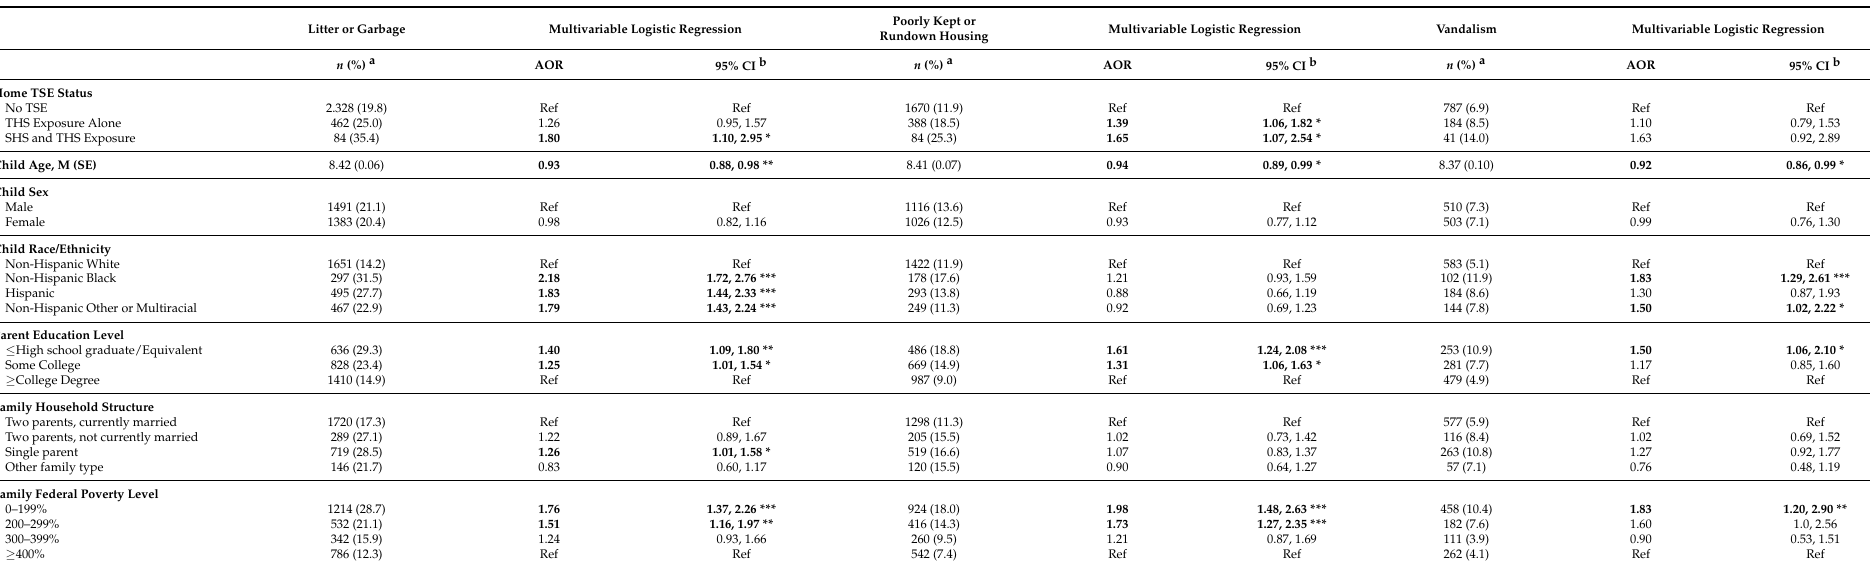
Table 5. Child home TSE status and type of detracting neighborhood elements among U.S. children 6-11 years old, 2018-2019